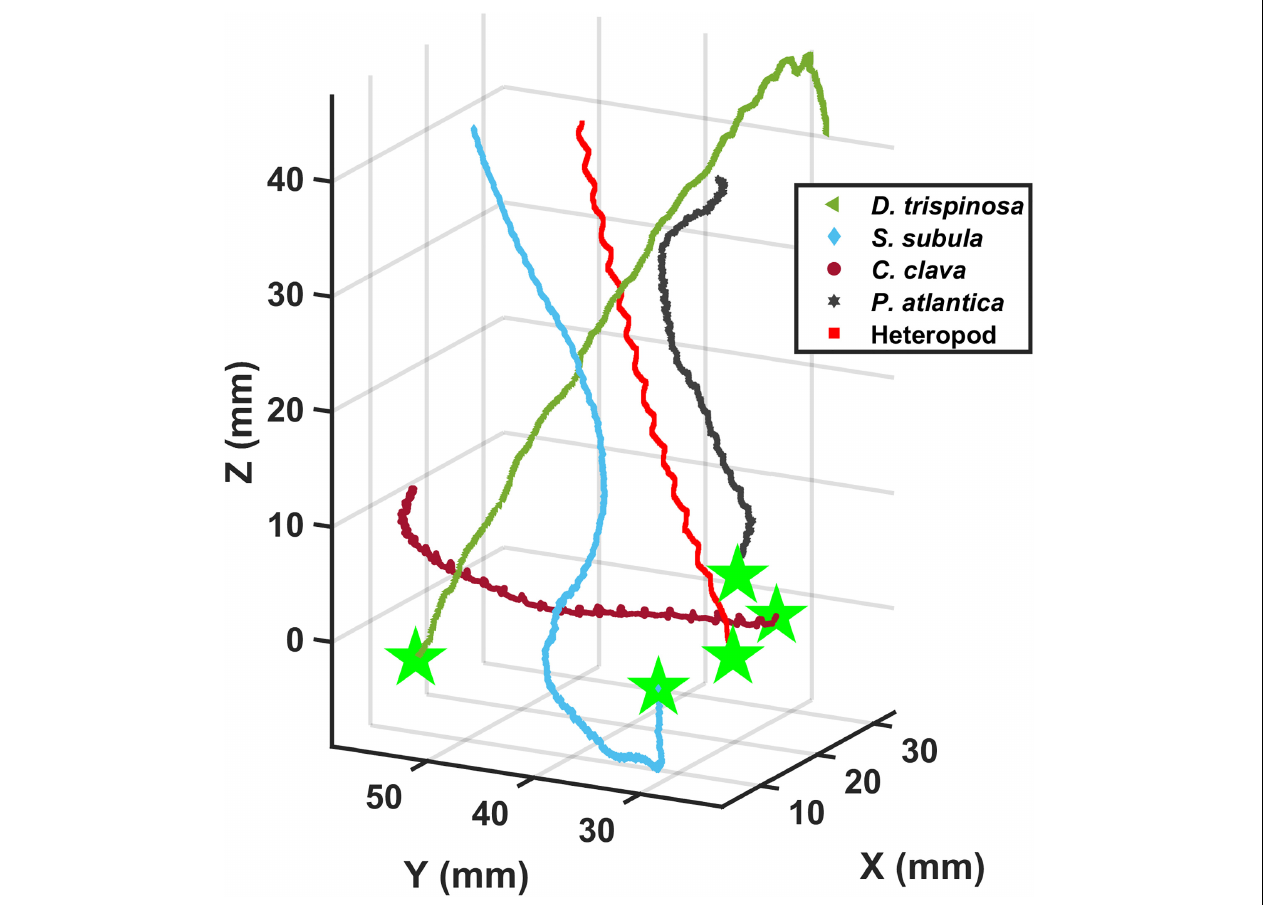
FIGURE 4 | Three-dimensional upward swimming trajectories of three thecosomatous pteropod species, one gymnosomatous pteropod species, and one atlantiid heteropod species.